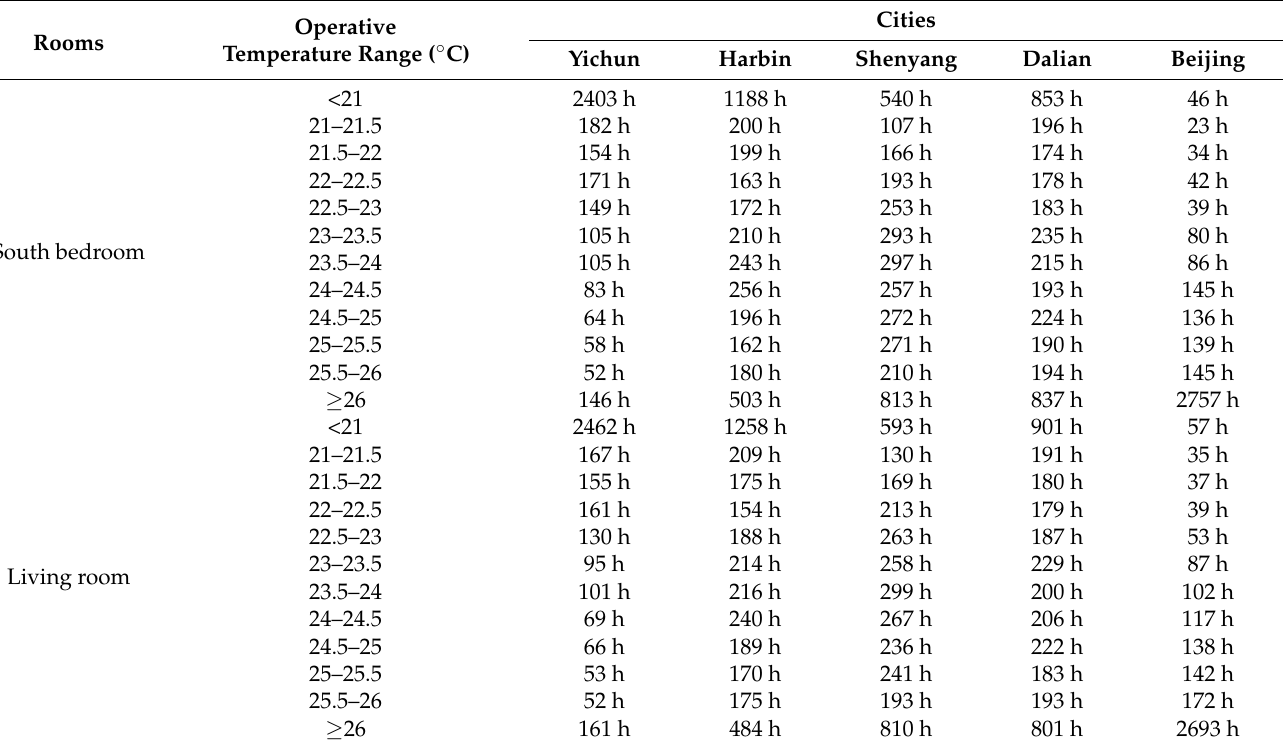
Table 15. The hours of each interval of indoor operative temperature in the south bedroom and living room on the 10th floor in five cities from May to